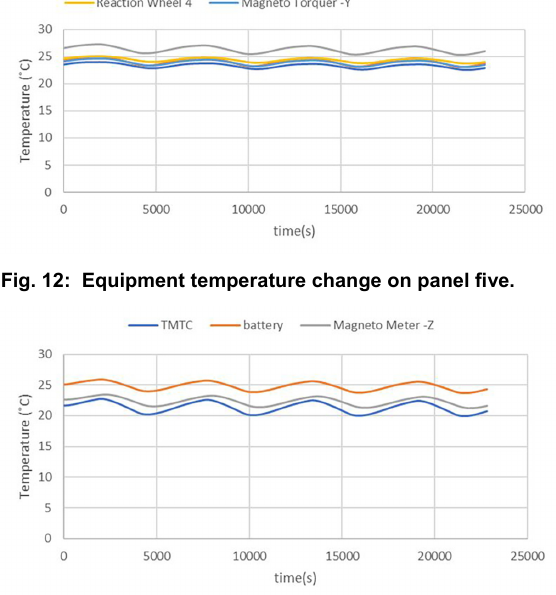
Fig. 13 Equipment temperature change on panel